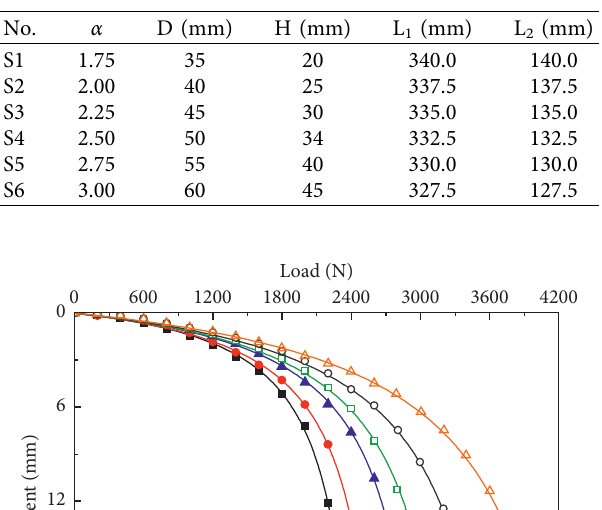
Figure 2: Load device and model pile: (a) load device; (b) reality of the model pile. Table 3: Model pile parameters. Table 4: Relative error analysis of the settlement above test piles (%).